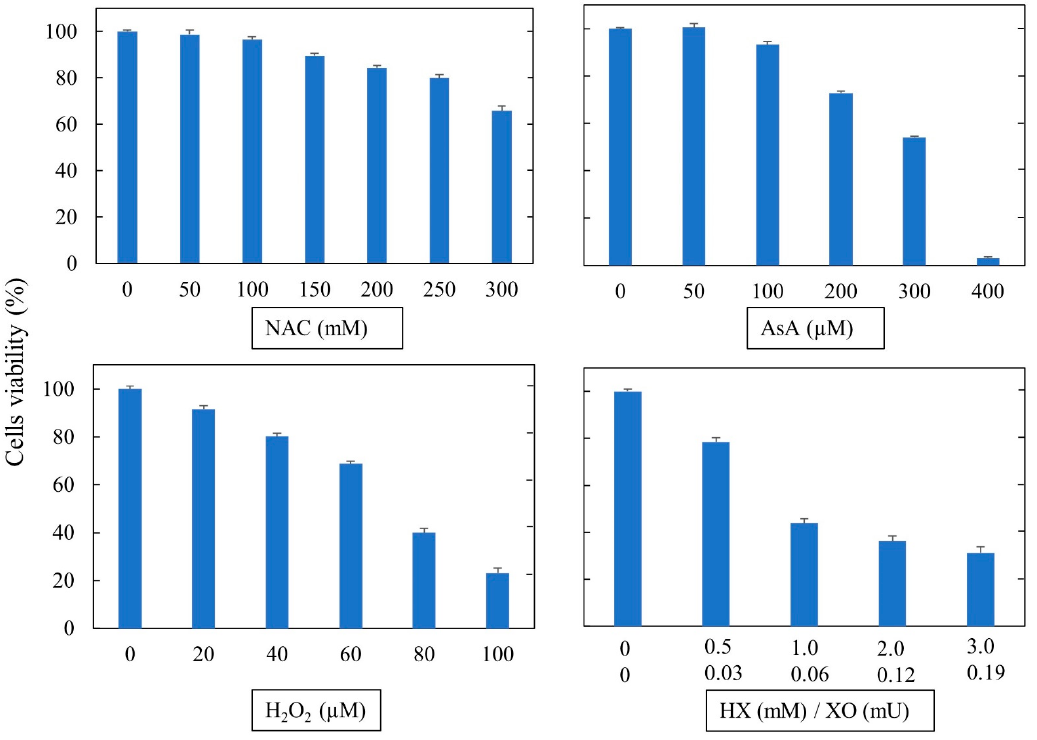
Figure 1. Evaluation of cytotoxicity of test compounds, as assessed by measuring PI incorporation in ACE2-HEK293 cells. The results are means ± SD of triplicates.